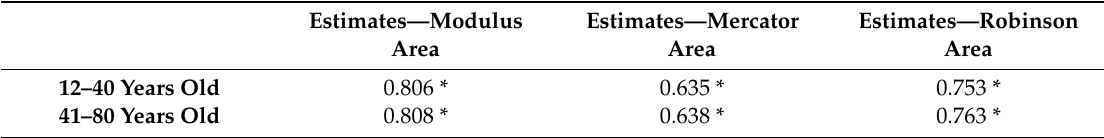
Table 4. Overview of the Pearson correlation coe ffi cients per age